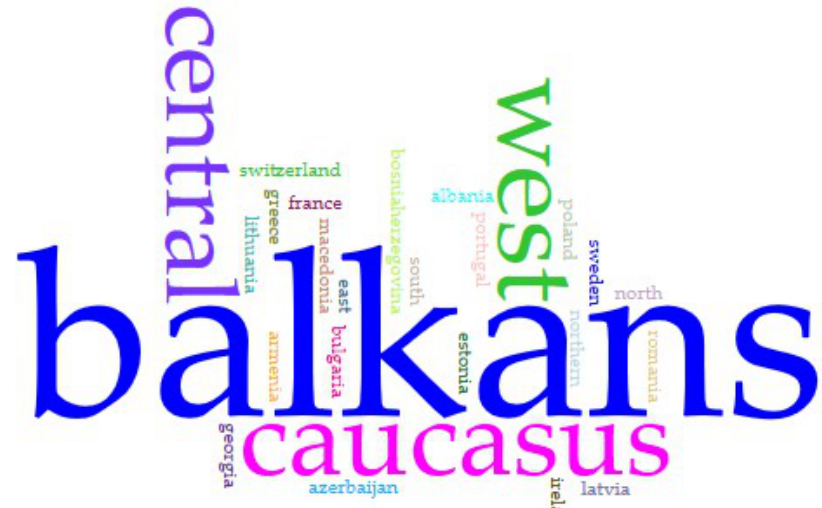
Figure 4. European Journeys by Francis (until the corona crisis 2020) (own figure, copyright by the